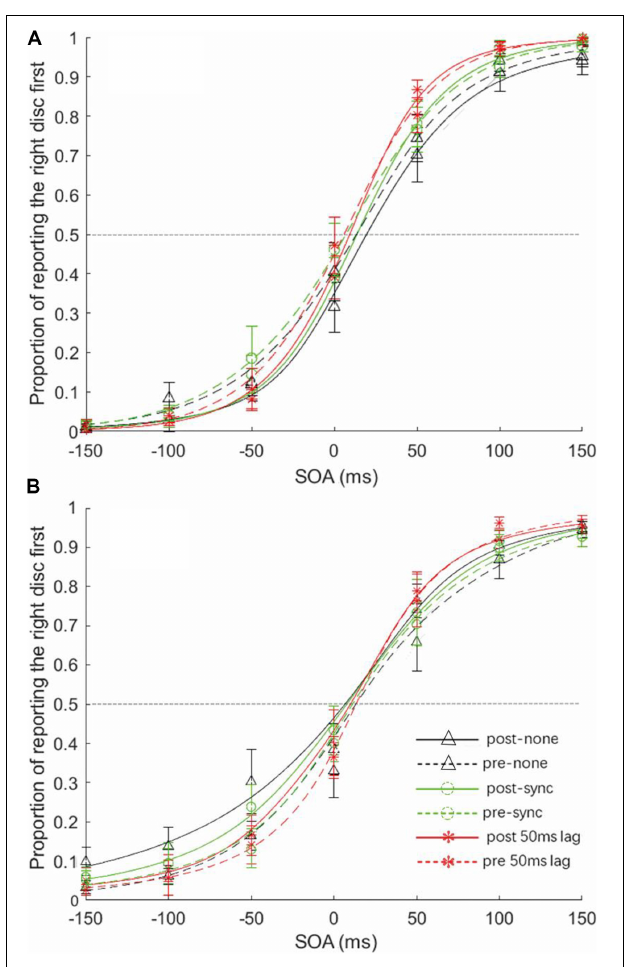
FIGURE 3 | Averaged psychometric curves. (A) The psychometric curves for the pre- and post-training test in the mindfulness-trained group. (B) The psychometric curves for the “pre” and “post” results in the control group. For both graphs, the solid lines represent post-test results, and the dotted lines represent pre-test results. The black lines represent the purely visual (no beeps) condition, the green lines represent the synchronous beeps condition, and the red lines represent the 50 ms lag beep condition. Error bars represent standard error.